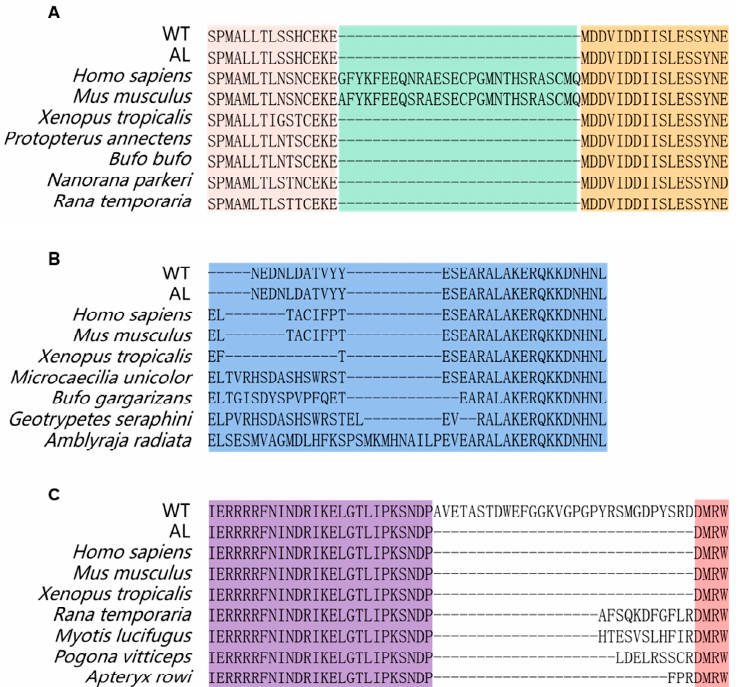
Figure 6. Unique structure of MITF in Andrias davidianus compared with other vertebrates. When comparing MITF protein sequences of Andrias davidianus with 328 other species, it was found that ( A ) Exon 3 of MITF was deleted in Andrias davidianus and a few other animals. ( B ) MITF in most animals either contains 6a (TACIFP) or does not contain 6a, while the sequence at 6a of MITF was altered to another sequence in the Andrias davidianus and a few other animals. ( C ) An insertion of 30 amino acids between exons 7 and 8 of MITF existed in the WT Andrias davidianus but not in albino Andrias davidianus and most other vertebrates.